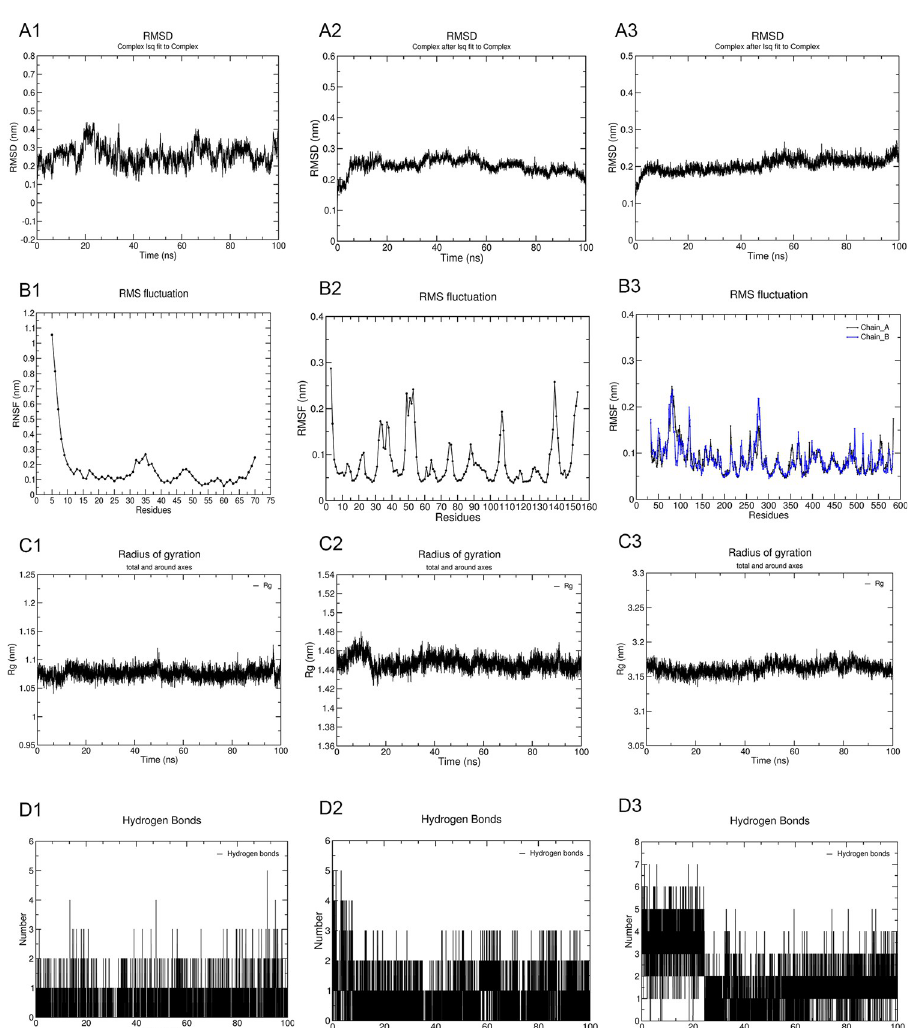
Fig 9. The results of molecular dynamics simulations. (A1-3) The RMSD of CCL2-quercetin, IL1B-quercetin and PTGS2-quercetin. (B1-3) The RMSF of CCL2-quercetin, IL1B-quercetin and PTGS2-quercetin. (C1-3) The Rg of CCL2-quercetin, IL1B-quercetin and PTGS2-quercetin. (D1-3) Number of hydrogen bond interactions of CCL2-quercetin, IL1B-quercetin and PTGS2-quercetin.